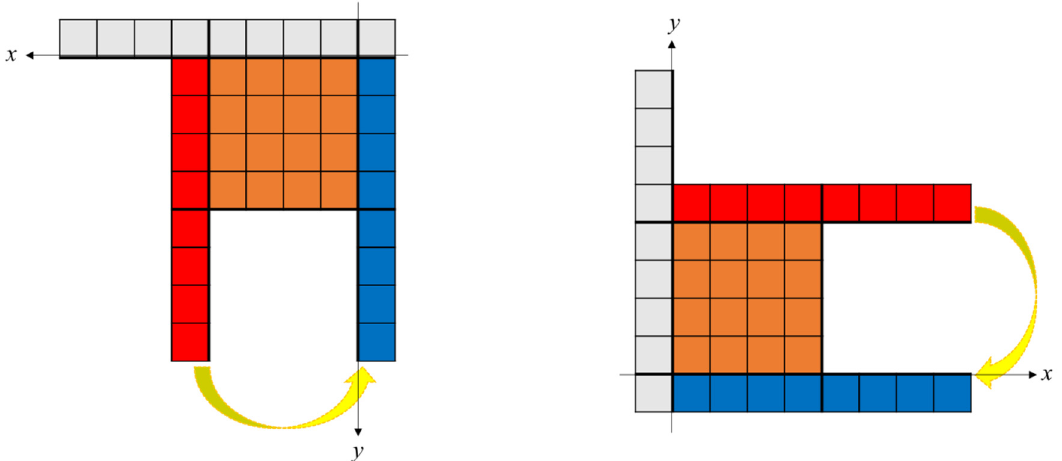
Figure 6. Translation of the xy -coordinate for the horizontal reference set (left) and the vertical reference set (right).